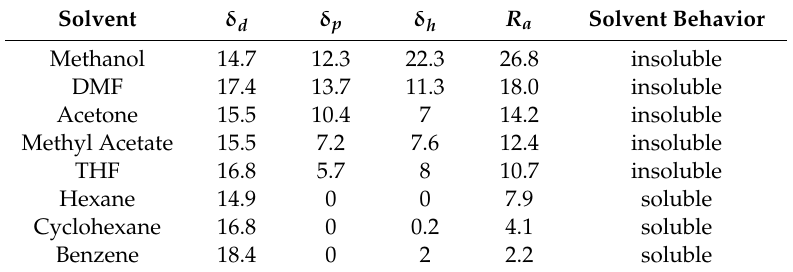
Table 4. Hansen solubility parameter and solvent behaviors of PB in common organic solvents. Unit: MPa 0.5